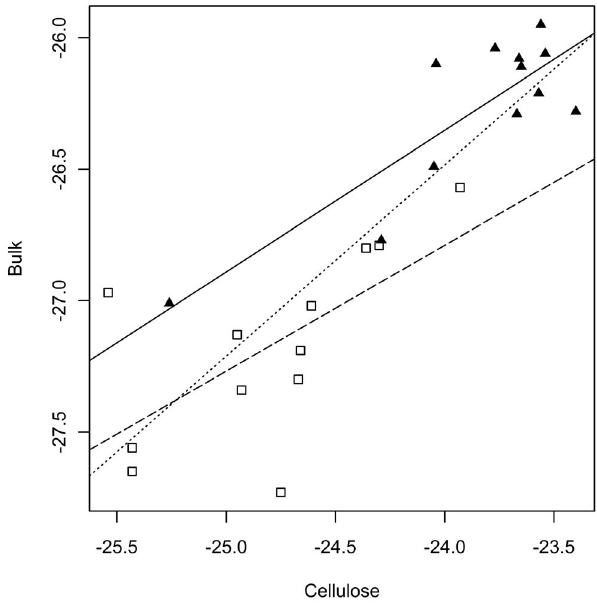
Figure 4. The d 13 C values of bulk fine root are plotted against cellulose extracts of the fine roots after nine years of irrigation. Irrigated values (open squares) show a reduction of d 13 C compared to the control (closed triangles). Dotted linear regression shows the overall correlation ( p , 0.001), the dashed line is the linear regression of the irrigated ratios ( p = 0.023) and the solid regression line belongs to the control ( p , 0.001), ( n = 4).